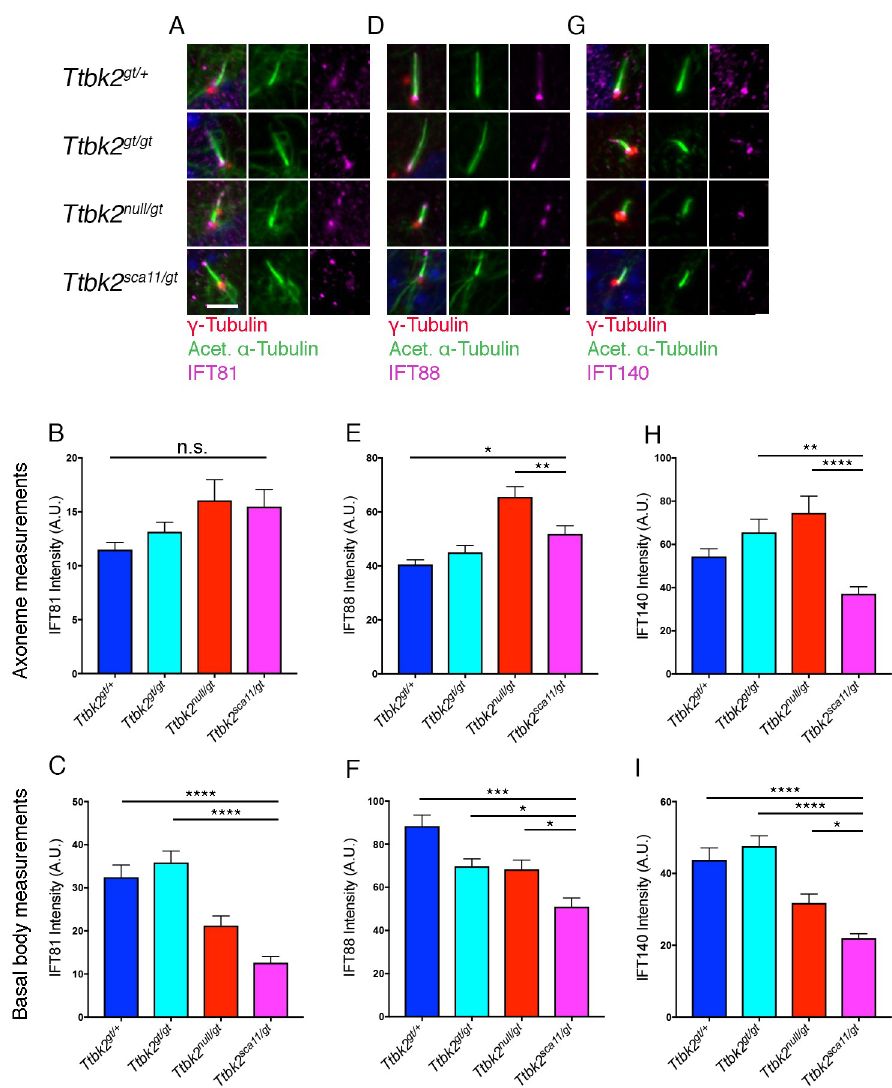
Fig 7. Localization of IFT proteins is perturbed in Ttbk2 hypomorphic alleles. (A-C) Immunostaining in MEFs of each indicated genotype for IFT81 (magenta), γ -Tubulin (red) to label centrosomes and Acetylated α -Tubulin (green) to label the cilia (A). Quantification of IFT81 pixel intensity throughout ciliary axoneme (B) or the basal body pool only (C). Quantification of pixel intensity throughout the axoneme is shown in (B) but was not statistically significant between indicated genotypes. IFT81 pools are depleted in Ttbk2 sca11/gt basal bodies compared to other genotypes (C). Statistical comparison was performed by 1-way ANOVA with Tukey-Kramer post-hoc test. (p < 0.0001 vs Ttbk2 gt/+ ; p = 0.0106 vs Ttbk2 gt/gt ; p = 0.0150 vs Ttbk2 null/gt ). Scale bar = 5 μ m. (D-F) Immunostaining of IFT88 (magenta) shows depleted staining at the basal body for Ttbk2 sca11/gt cells (D). Quantification of pixel intensity throughout the axoneme is shown in (E). Statistical comparison was performed by 1-way ANOVA with Tukey-Kramer post-hoc test. (p = 0.0282 vs Ttbk2 gt/+ ; p = 0.0052 vs Ttbk2 null/gt ). Quantification of pixel intensity at the basal body is shown in (F). Statistical comparison was performed by 1-way ANOVA with Tukey-Kramer post-hoc test. (p < 0.0001 vs Ttbk2 gt/+ ; p < 0.0001 vs Ttbk2 gt/gt ; p = 0.0647 vs Ttbk2 null/gt ). (G-I) Immunostaining of IFT140 (magenta) shows reduced intensity in Ttbk2 sca11/gt cells(G). Quantification of pixel intensity throughout the axoneme is shown in (H). Ttbk2 sca11/gt axonemes have less IFT140 compared to other genotypes. Statistical comparison was performed by 1-way ANOVA with Tukey-Kramer post-hoc test. (p = 0.0022 vs Ttbk2 gt/gt ; p < 0.0001 vs Ttbk2 null/gt ). Quantification of pixel intensity at the basal body is shown in (I). Statistical comparison was performed by 1-way ANOVA with Tukey-Kramer post- hoc test. (p < 0.0001 vs Ttbk2 gt/+ ; p < 0.0001 vs Ttbk2 gt/gt ; p = 0.0484 vs Ttbk2 null/gt ). n = 50 or more basal bodies and cilia pooled from 3 biological